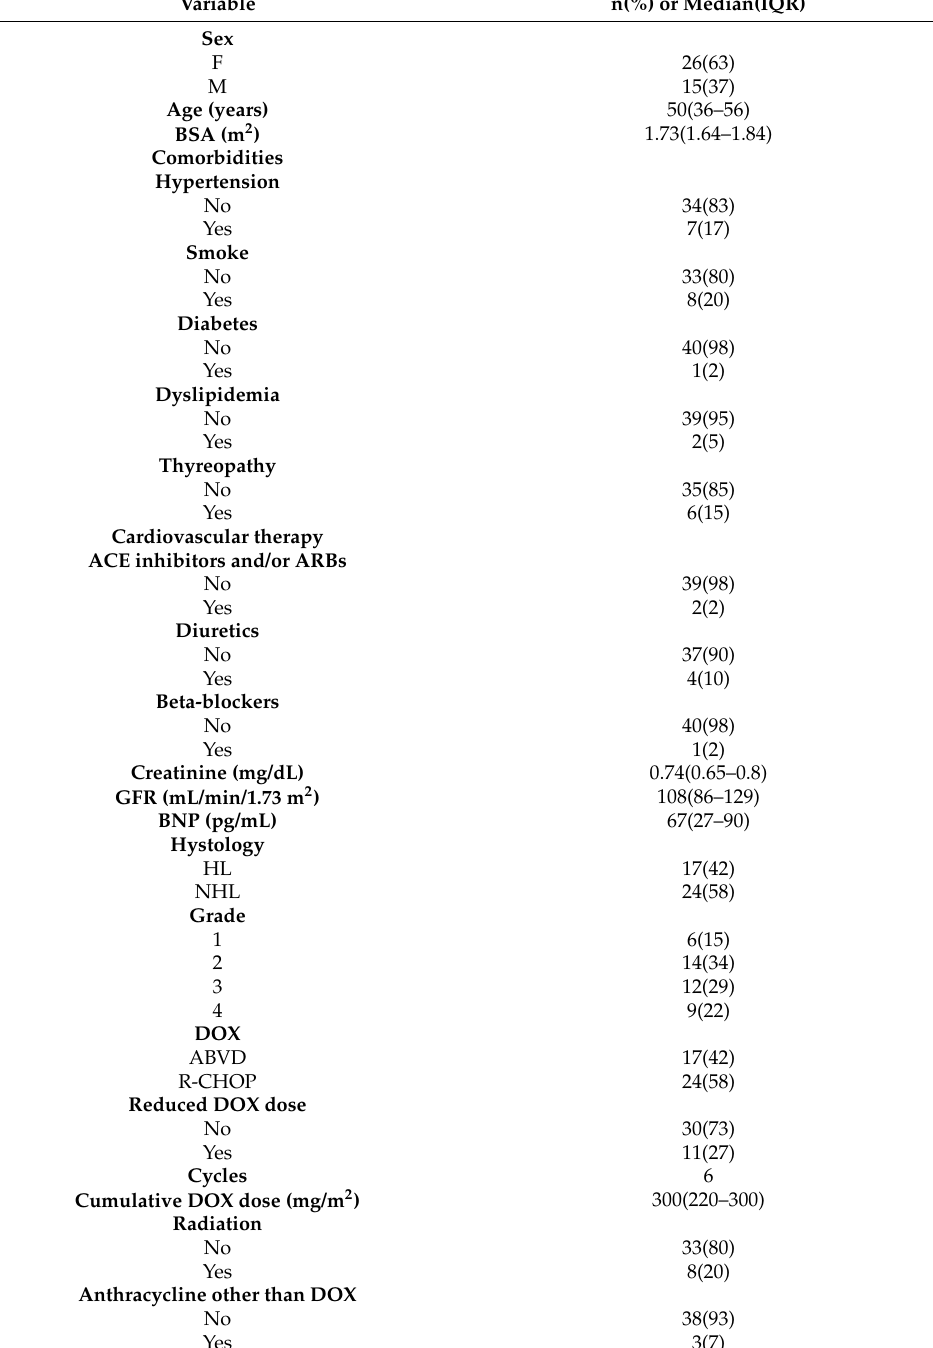
Table 1. Baseline